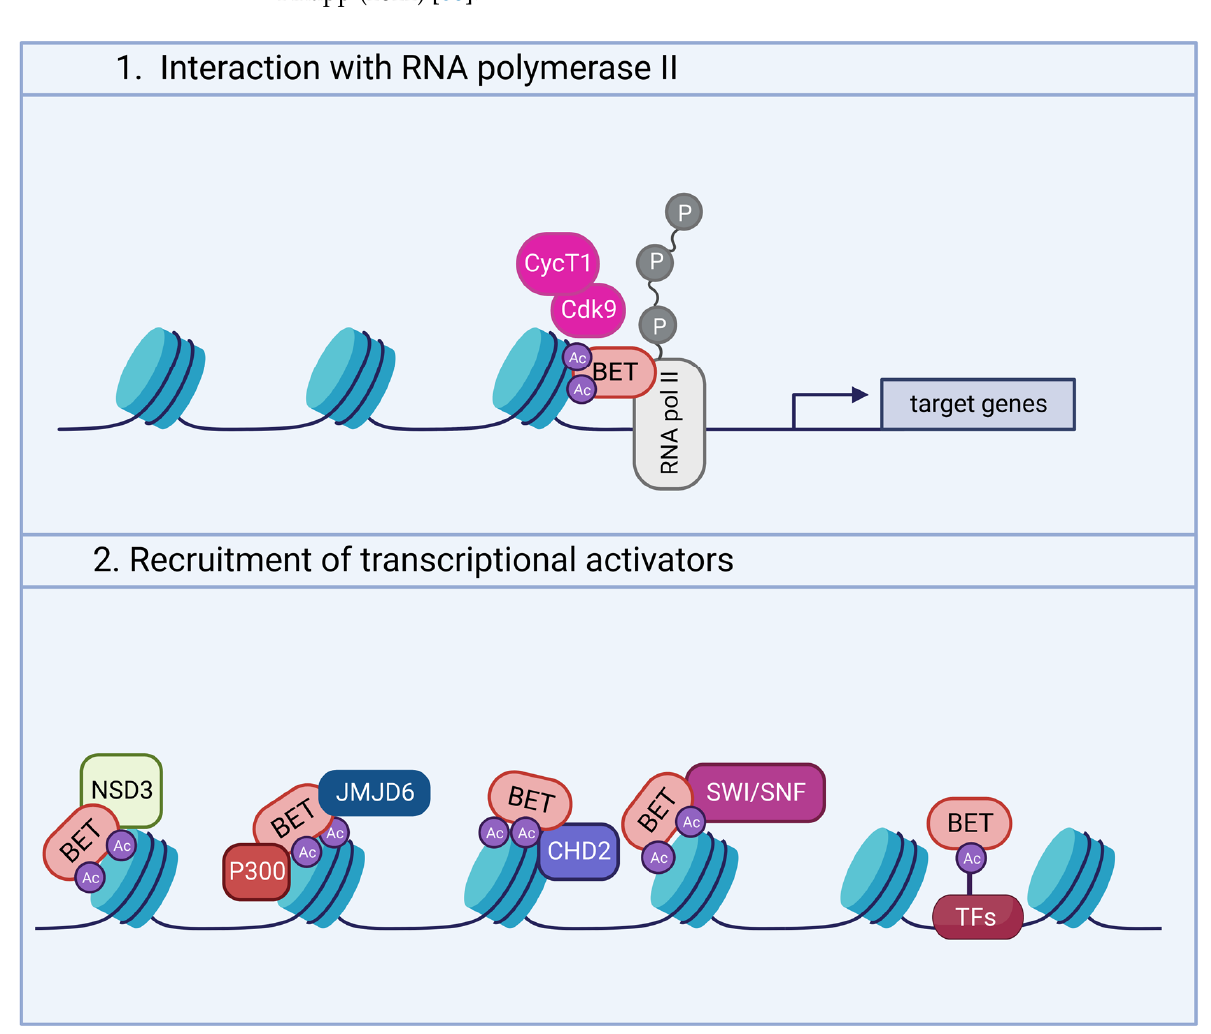
Figure 1. Transcriptional regulatory mechanisms mediated by BET proteins. ( 1 ) Binding of BET pro- teins to acetylated histones results in interaction with the p-TEFb elongation complex (CDK9/CycT1), promoting phosphorylation of the C-terminal domain of RNA polymerase II and transcription of target genes. ( 2 ) BET protein-mediated recruitment of transcriptional activators, such as histone demethylase JMJD6, CBP/p300 HAT, methyltransferase NSD3, and the nucleosome remodeling complexes SWI/SNF and CHD2, leads to changes in chromatin structure. Furthermore, BET proteins are also able to bind other acetylated proteins such as TFs, modulating transcription. This figure is created with BioRender.